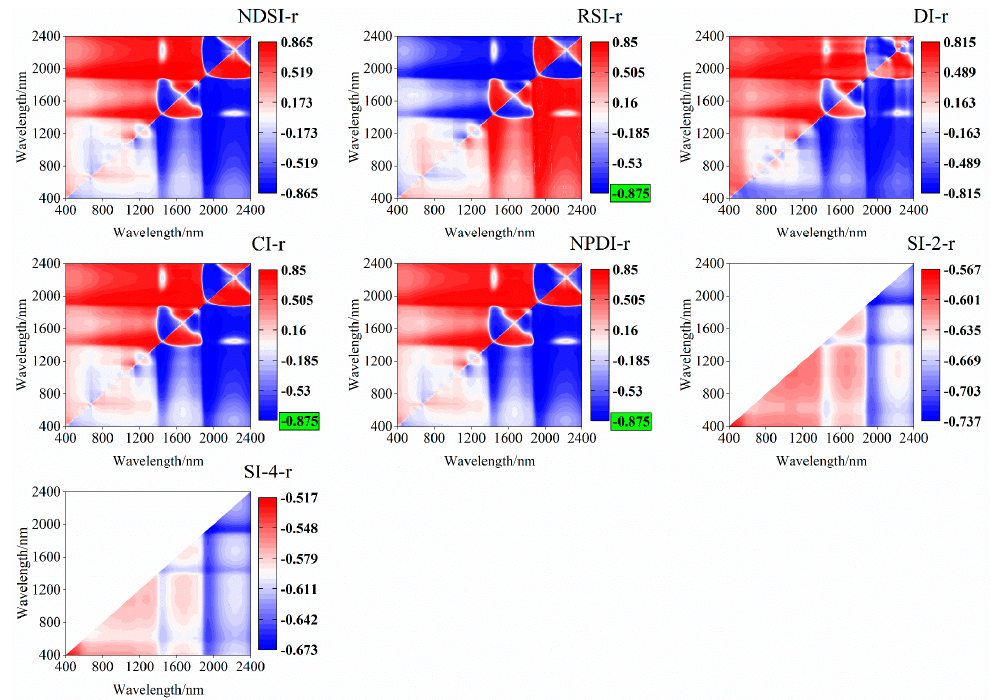
Figure 11. Two-dimensional r diagram of SMC and original spectrum of 400–2400 nm.